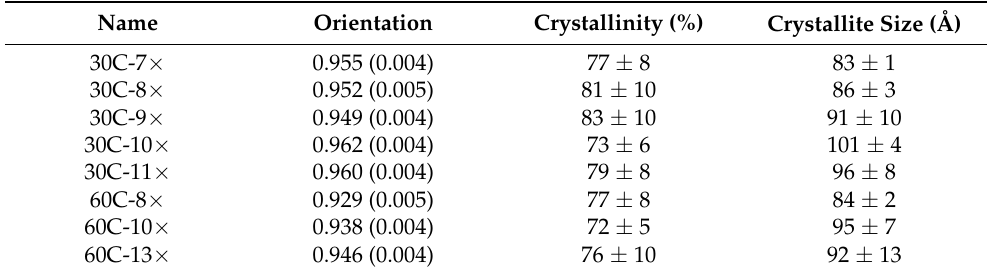
Table 3. The orientation, crystallinity, and the crystallite size as measured using XRD for the WFs investigated in this study. Standard deviations are indicated in the round brackets, while experimental error is indicated after the ± sign.